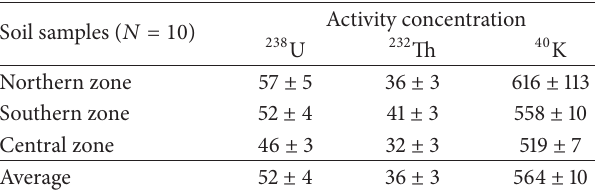
Table 2: The average activity concentration of radionuclides in the collected soil samples (Bq/kg ± SEM).